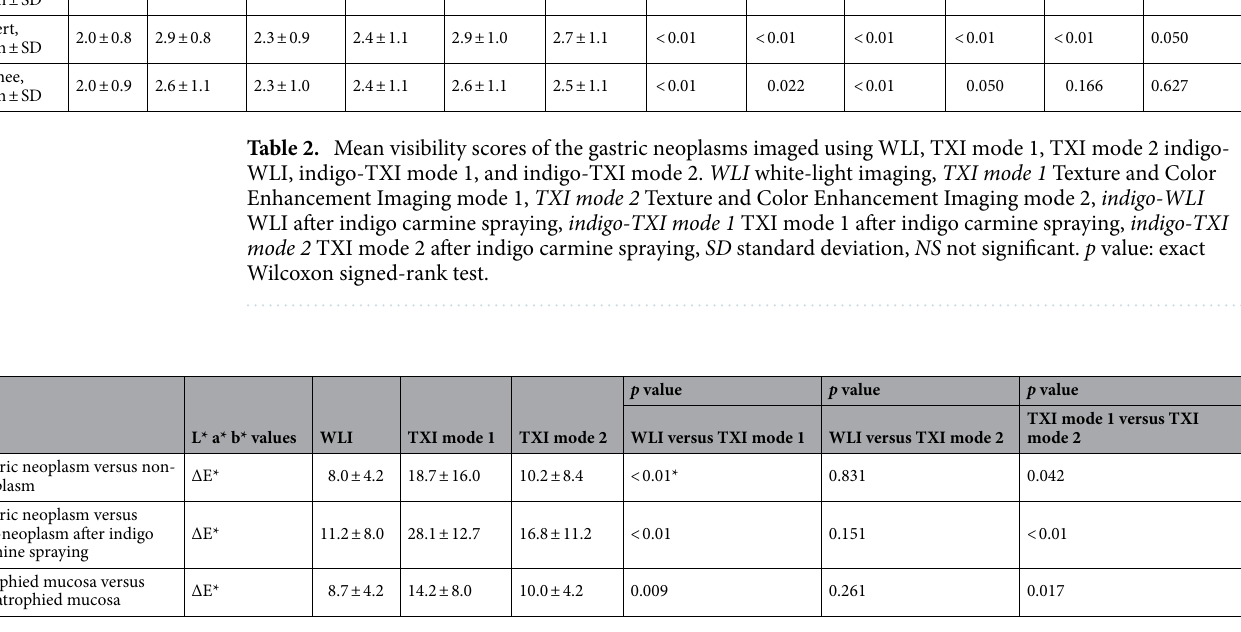
Color difference between gastric neoplasm and non-neoplastic areas. The color difference (ΔE) between neoplastic and non-neoplastic areas was significantly higher for TXI mode 1 than for WLI [8.000 ± 4.263 vs. 18.728 ± 16.046, p < 0.01]. TXI mode 1 also showed a significantly higher color difference than TXI mode 2 [18.728 ± 16.046 vs. 10.246 ± 8. 379, p = 0.042]. Meanwhile, color difference between WLI and TXI mode 2 was not significant (8.000 ± 4.263 vs. 10.246 ± 8.397, p = 0.831). Table 3 lists the color differences, including the results